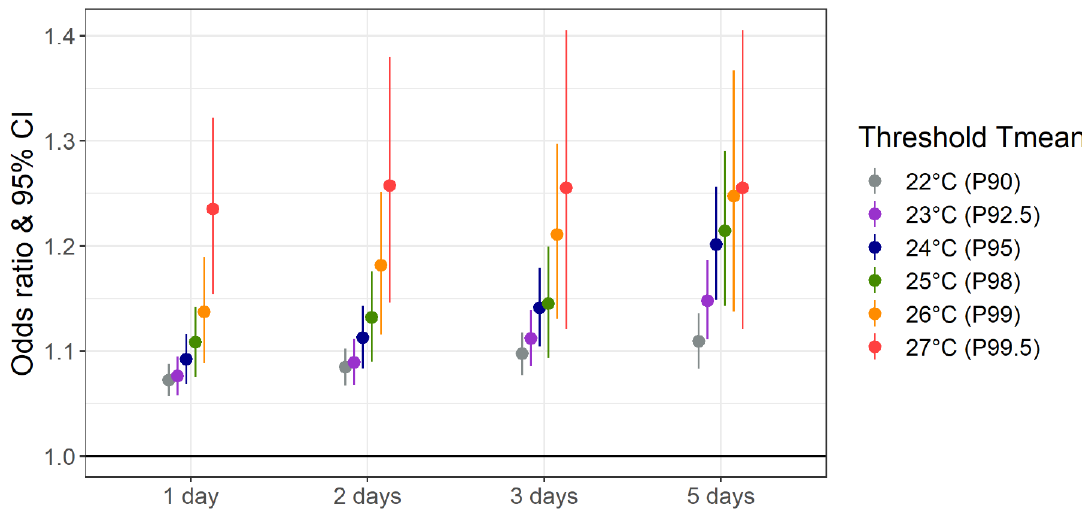
Figure 5. Effect of different heatwave definitions on mortality in Switzerland. Effects are shown for different daily mean temperature (Tmean) thresholds and days of duration, expressed as odds ratio (OR) comparing heatwave to non-heatwave days. P refers to the warm-season percentile of Tmean.